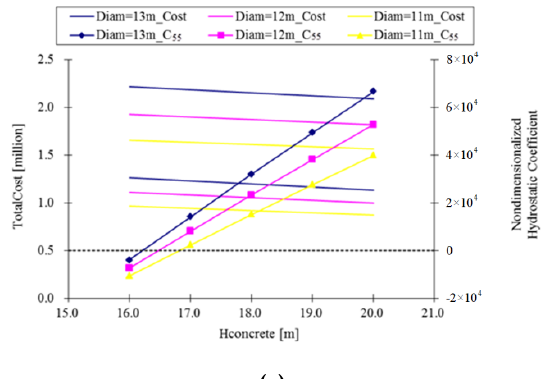
Figure 5. Hydrostatic stiffness and total cost for three cases: ( a ) platform steel wall thickness (SWT) = 0.015 m; ( b ) SWT = 0.0253 m; ( c ) SWT = 0.045 m. The solid line without a marker represents the upper and lower limits for the platform cost of the corresponding H concrete . The black dash line represents when hydrostatic coefficient equals 0.